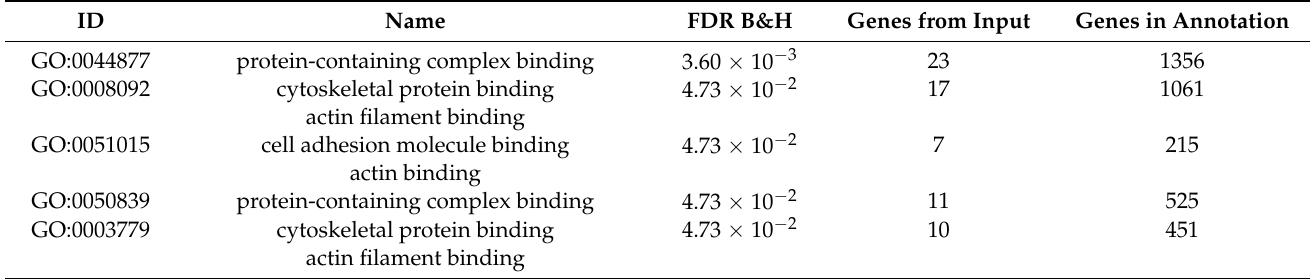
Table 2. Molecular functions regulated by Activin-A in FOP cells.